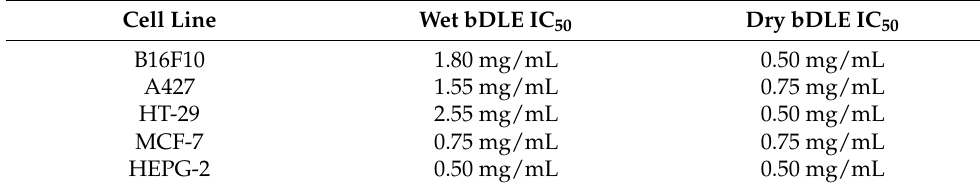
Table 3. Wet and dry bDLE IC 50 for B16F10, A427, HT-29, MCF-7 and HEPG-2 cancer cell